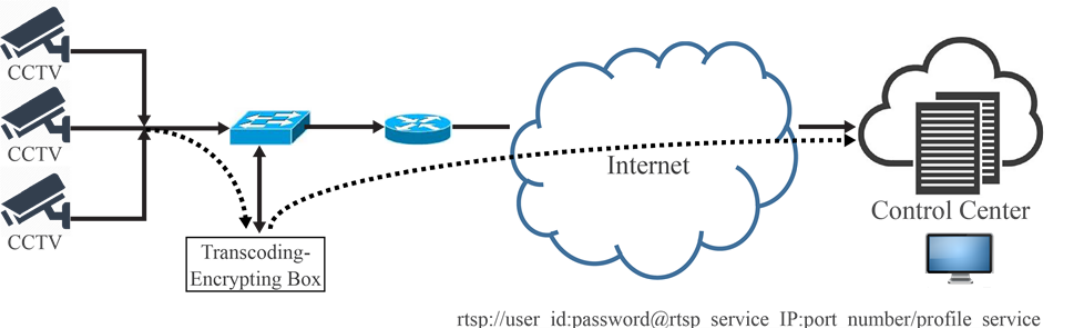
Figure 1. Conceptual architecture of live CCTV System with real-time